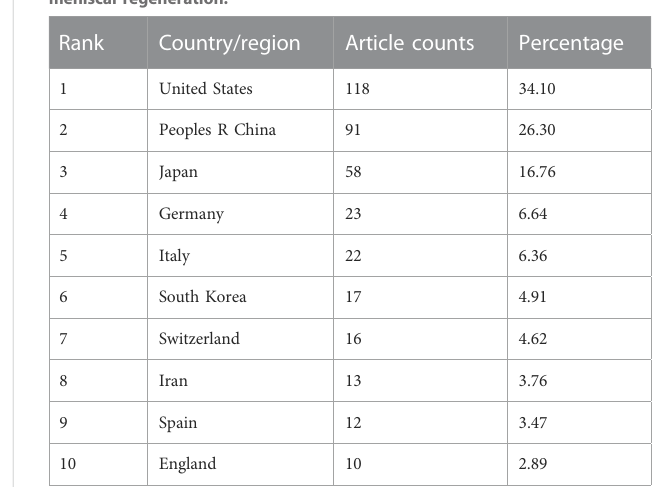
TABLE 1The top10mostproductive countries/regions related tostem cellsfor meniscal